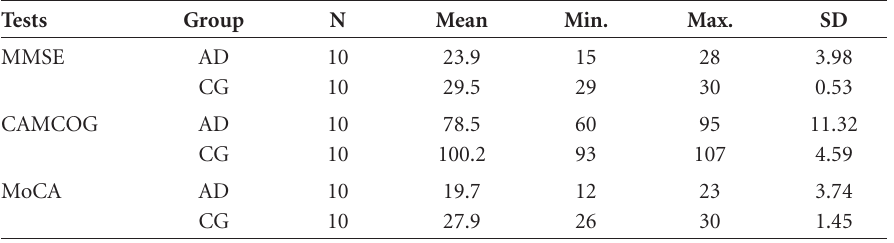
Table 1. Scores of 20 subjects on cognitive tests.